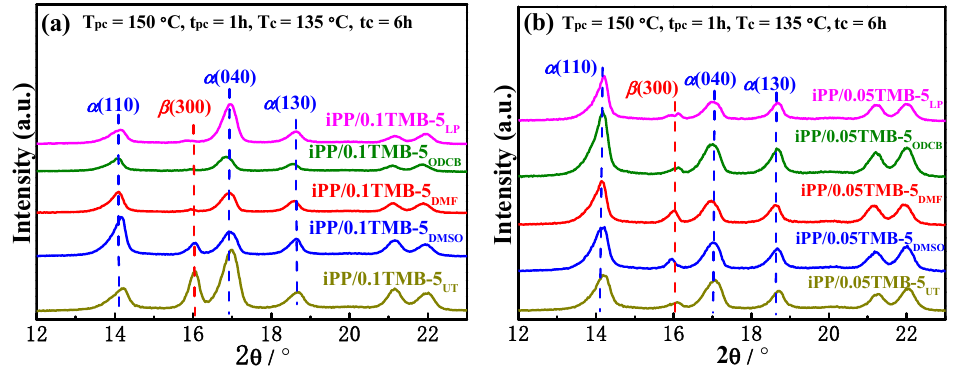
Figure 8. WAXD profiles of different TMB-5 nucleated iPP statically crystallized at T c = 135 °C for 6 h after a pre-crystallization at T pc = 150 °C for 1 h, the NA content is ( a ) 0.1 wt% and ( b ) 0.05